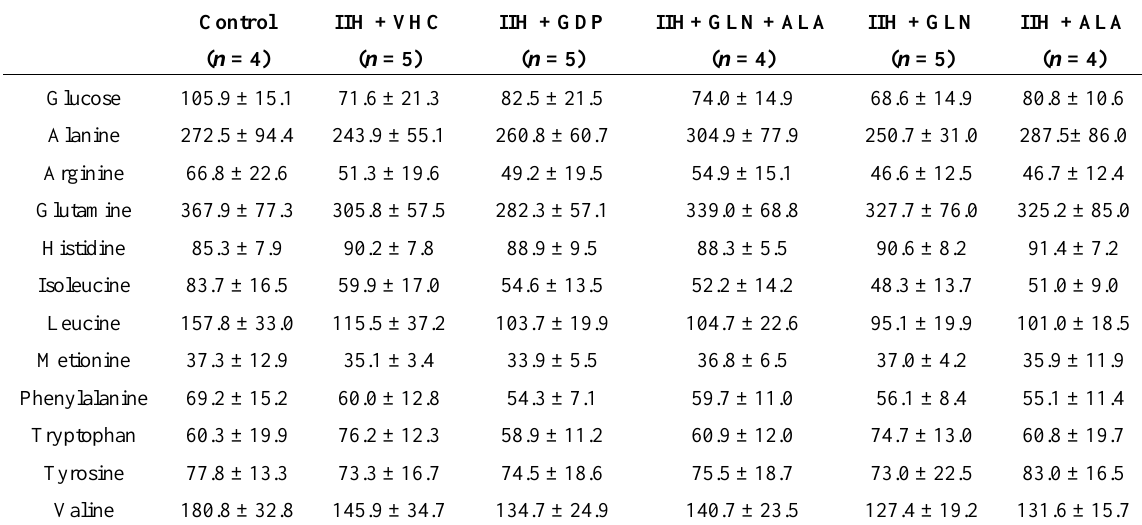
Table 2. Blood glucose (mg/dL) and amino acid (nmol/mL) levels 30 min after intraperitoneal insulin injection (IIH group). The IIH group was divided into 5 subgroups: IIH + oral vehicle (VHC), IIH + oral glutamine dipeptide (GDP), IIH + oral glutamine (GLN) + oral alanine (ALA), IIH + oral GLN or IIH + oral ALA. GDP (100 mg/kg), GLN (61.9 mg/kg) + ALA (38.1 mg/kg), GLN (61.9 mg/kg) or ALA (38.1 mg/kg) or VHC. The Control group received intraperitoneal saline + oral VHC. Data expressed as means ± standard error were analyzed by ANOVA (Newman-Keuls post hoc test).